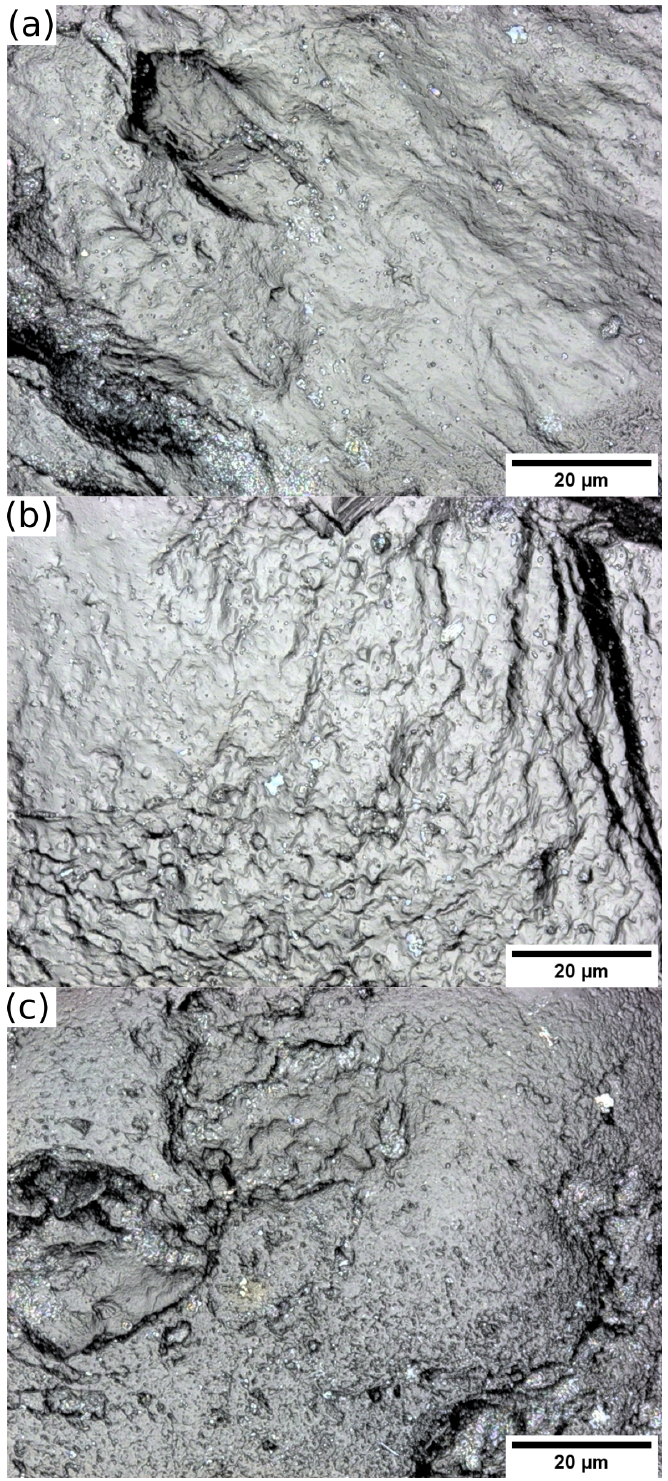
Figure 3. Surface images of ( a ) Ottawa sand, ( b ) Q-Rok, and ( c ) Siligran from high resolution confocal laser